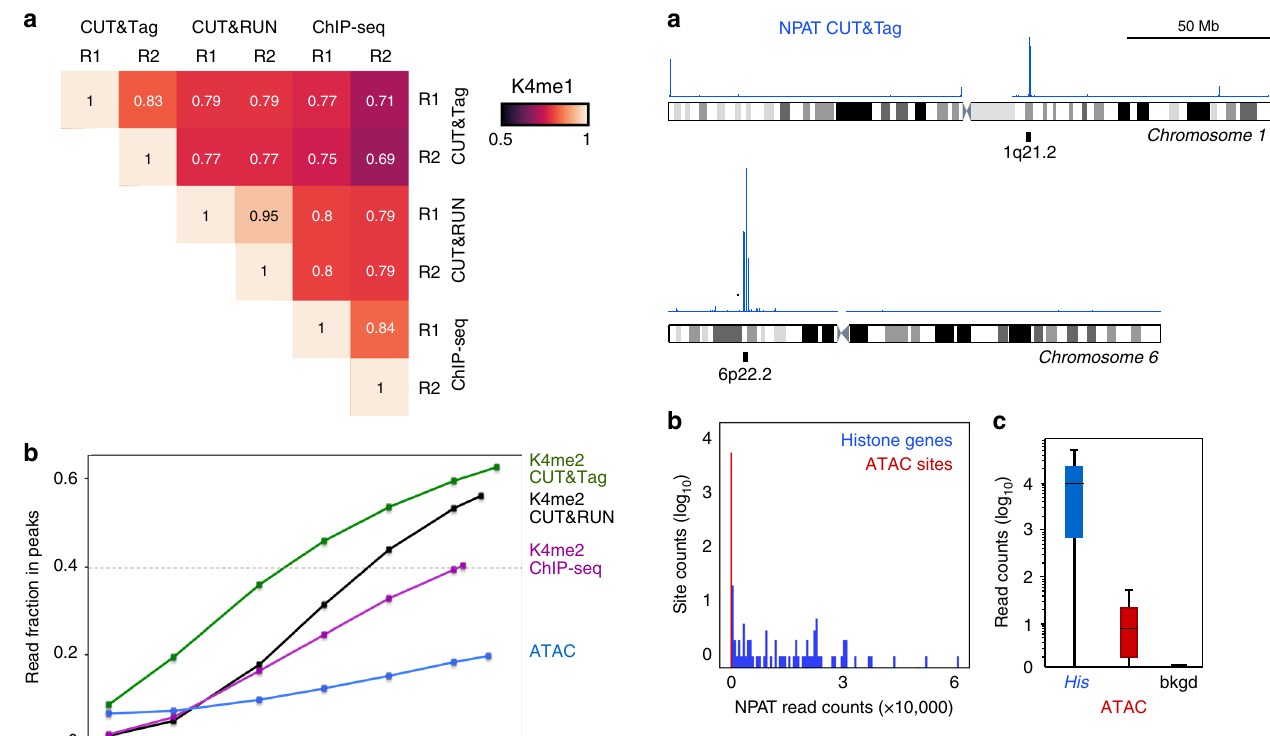
ATAC-de fi ned accessible sites (Supplementary Fig. 4). While this is only a fraction of the ~54,000 accessible sites de fi ned in K562 cells, adjusting the threshold and stringency of NPAT peak calling may improve detection.